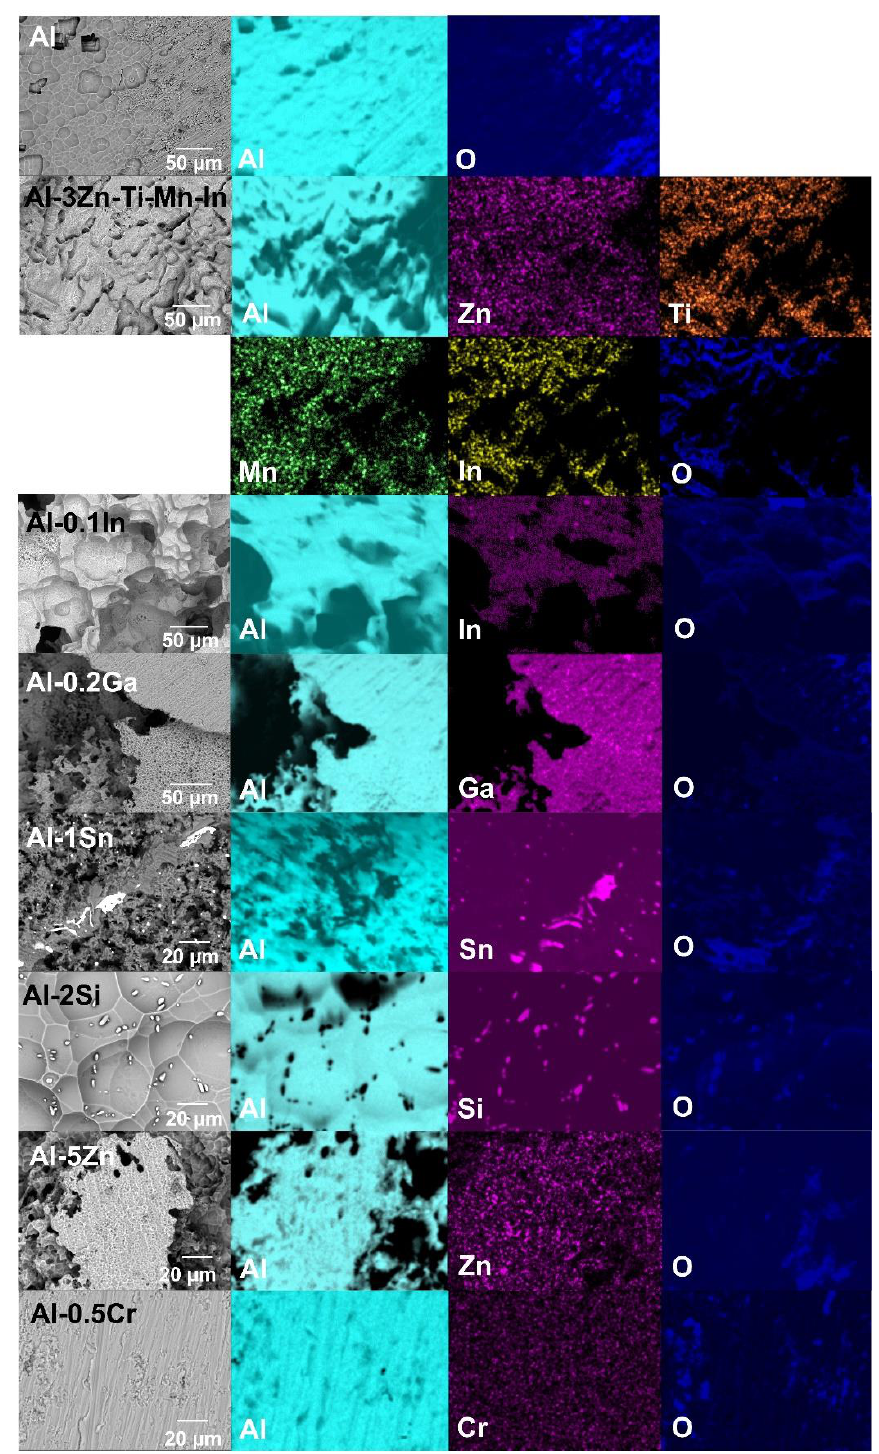
Figure 11. SEM-EDS elemental maps after removal of corrosion-product layer with phosphoric acid solution of the Al-based alloys after galvanic coupling with mild steel.